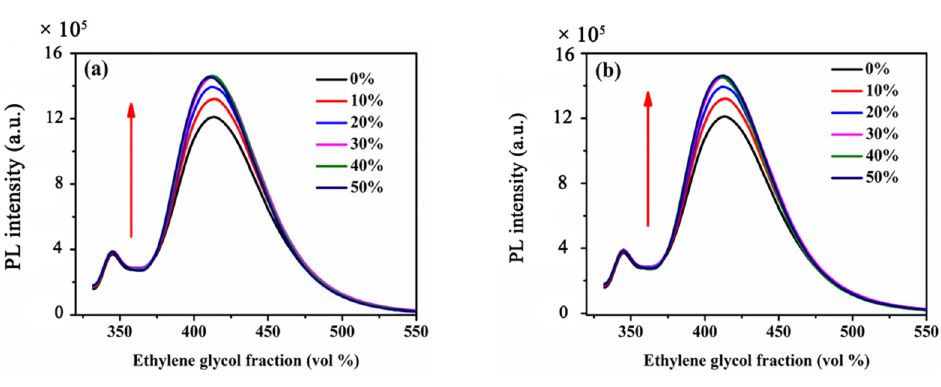
Figure 4. Fluorescence spectra of compounds in the mixed solutions of CH 3 OH/EG ( v : v ) ( a ) 1 , ( b ) 2 .